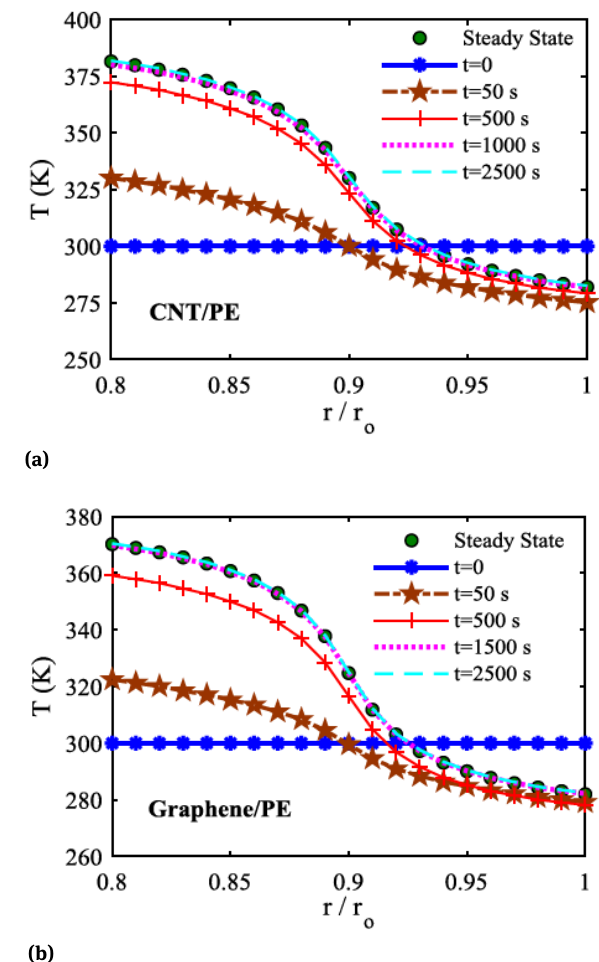
Figure 5: Steady state and transient temperature profiles along the thickness of (a) X-CNT/PE (b) X-graphene/PE cylinders at different